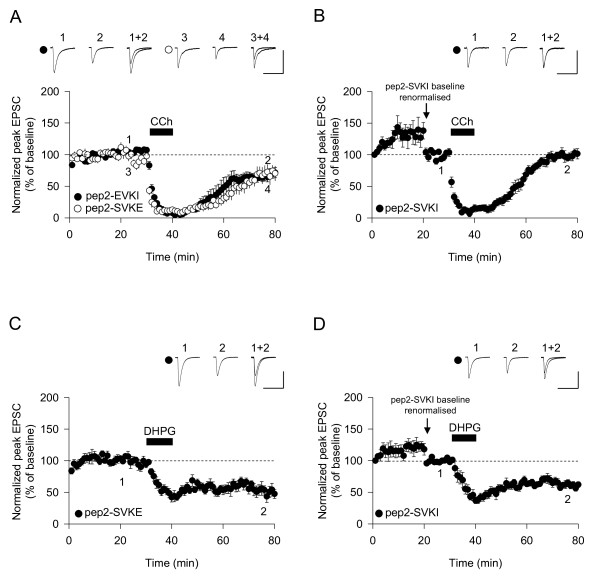
Interactions between GluA2 and GRIP, but not PICK1, are required for mAChR-LTD. (A) Neither pep2-SVKE (n = 6) nor pep2-EVKI (n = 9) has any effect on mAChR-LTD. (B) Pep2-SVKI prevents mAChR-LTD (n = 8). (C) Pep2-SVKE (n = 6) has no effect on mGluR-LTD. (D) Pep2-SVKI (n = 6) has no effect on mGluR-LTD.